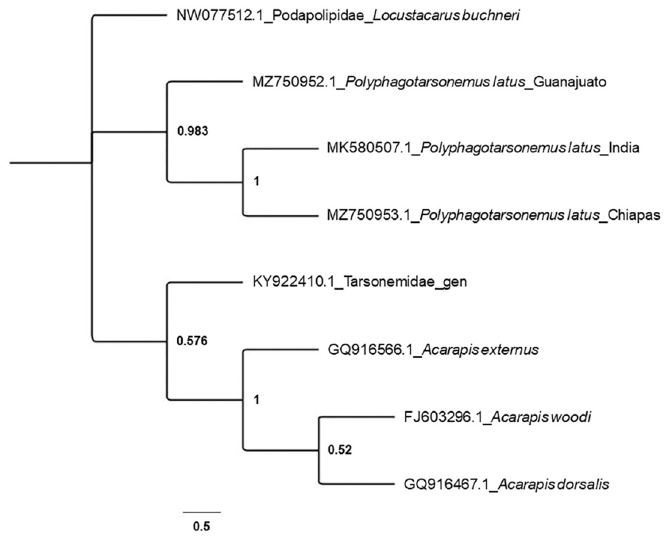
Fig 5. Consensus tree of the family Tarsonemidae represented in the Genbank. The tree was constructed based on sequences of mitochondrial COI fragments, with maximum likelihood and based on general time reversible model. The bootstrap consensus tree was inferred from 1000 replicates and used the family Podapolipidae as outgroup.